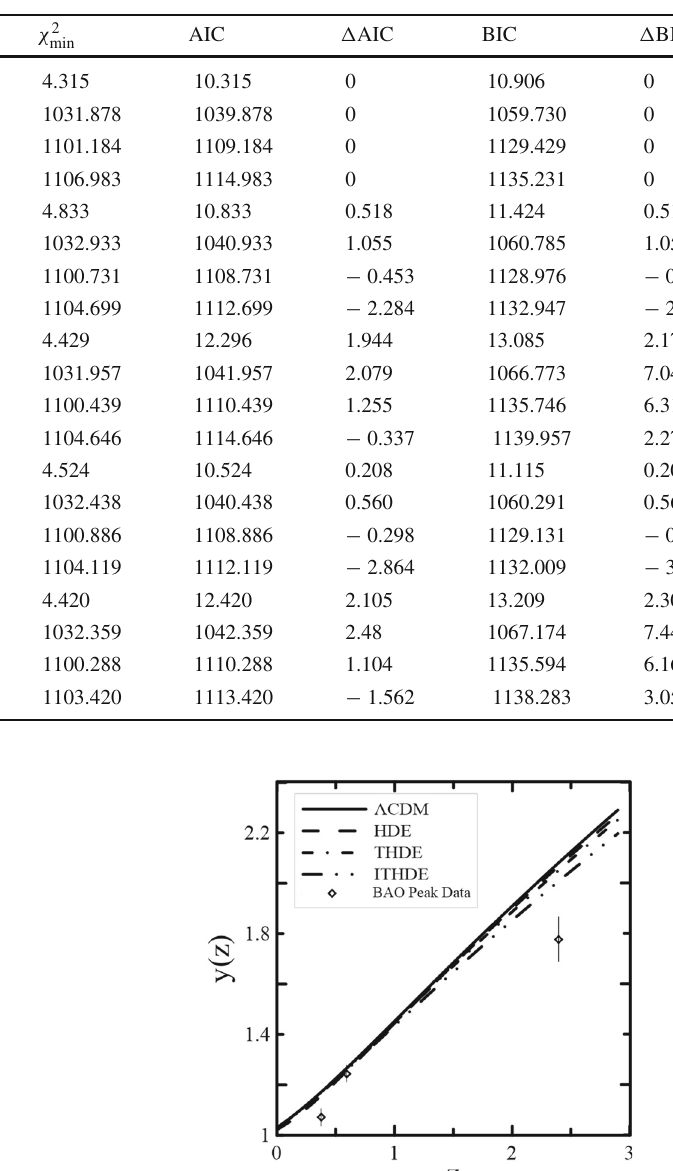
Table 5 Summary of the AIC and BIC values calculated for interact- ingandnon-interactingTHDEmodelwithrespecttothereferenceHDE model. (cid:10) AIC = AIC i − AIC HDE and (cid:10) BIC = BIC i − BIC HDE in which i denotes the number of models { i = 1 , 2 ,..., N } with N = 5